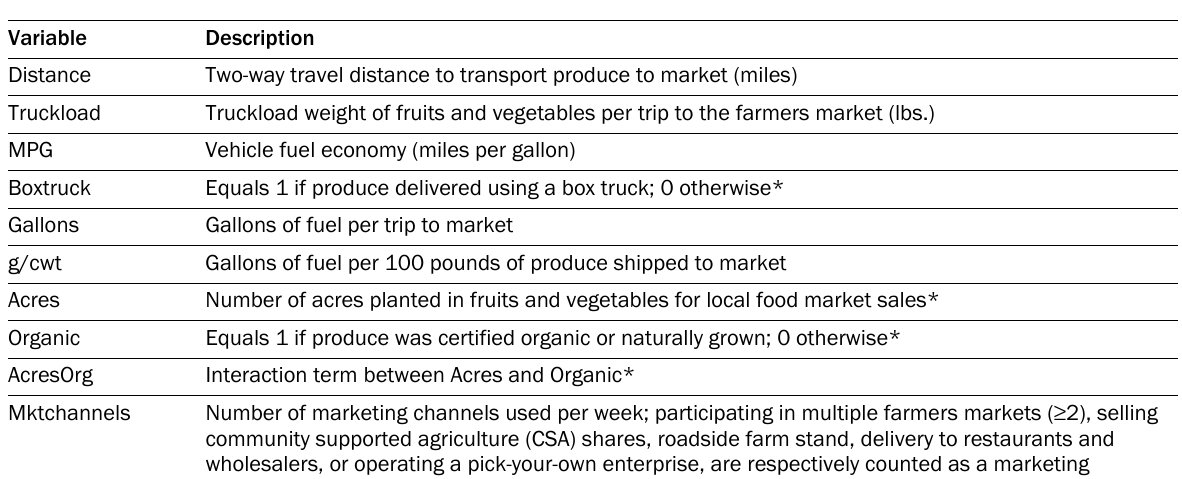
Table 1. Description of Local Farmer Survey Data Variable